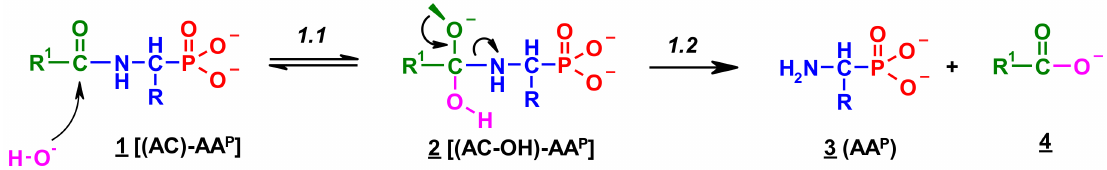
Scheme 1. Hypothetical mechanism of deacylation of (AC)-AA P in 2 M KOH